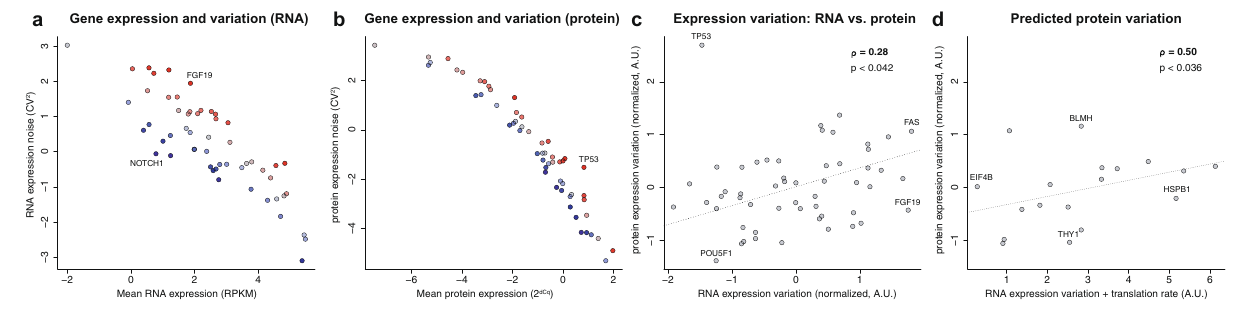
Fig. 4 RNA variation is not predictive for protein variation. Patterns of gene expression variation at steady-state in S-phase cells. a Relation between mean RNA expression mean (RPKM) and RNA expression variation (CV 2 ). Colors indicate variably (red) or stably (blue) expressed genes. b Similar to a , but for protein. c Normalized gene expression variation (residuals) at the RNA and protein levels correlate moderately (Spearman ’ s rho = 0.28). Genes of interest are indicated. d A simple additive model of RNA variation and estimated translation rate effectively predicts protein expression variation (Spearman ’ s rho = 0.50). A subset of genes from Fig. 3c are included here, as public data were not available to estimate translation rate for all genes